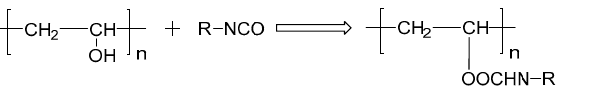
Figure 3. Crosslink density of EPI films at 80% RH with respect to crosslinker loading.